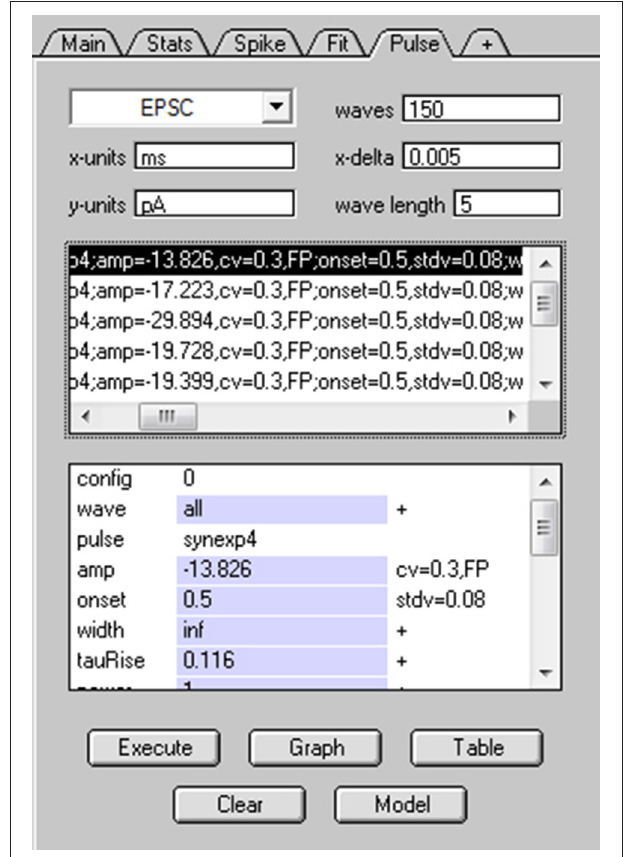
FIGURE 11 | Simulating stochastic synaptic release via NeuroMatic’s Pulse tab. Screen capture of NeuroMatic’s Pulse tab after clicking the Model button, selecting “Granule Cell Multinomial Synapse” and entering the following parameters via NeuroMatic’s prompts: N = 5, Q p = − 20pA, P = 0.5, CV QS = 0.3, σ QL = 0.08ms, CV QII = 0.3, no spillover. The time course of quantal release at each site was automatically set to the NeuroMatic